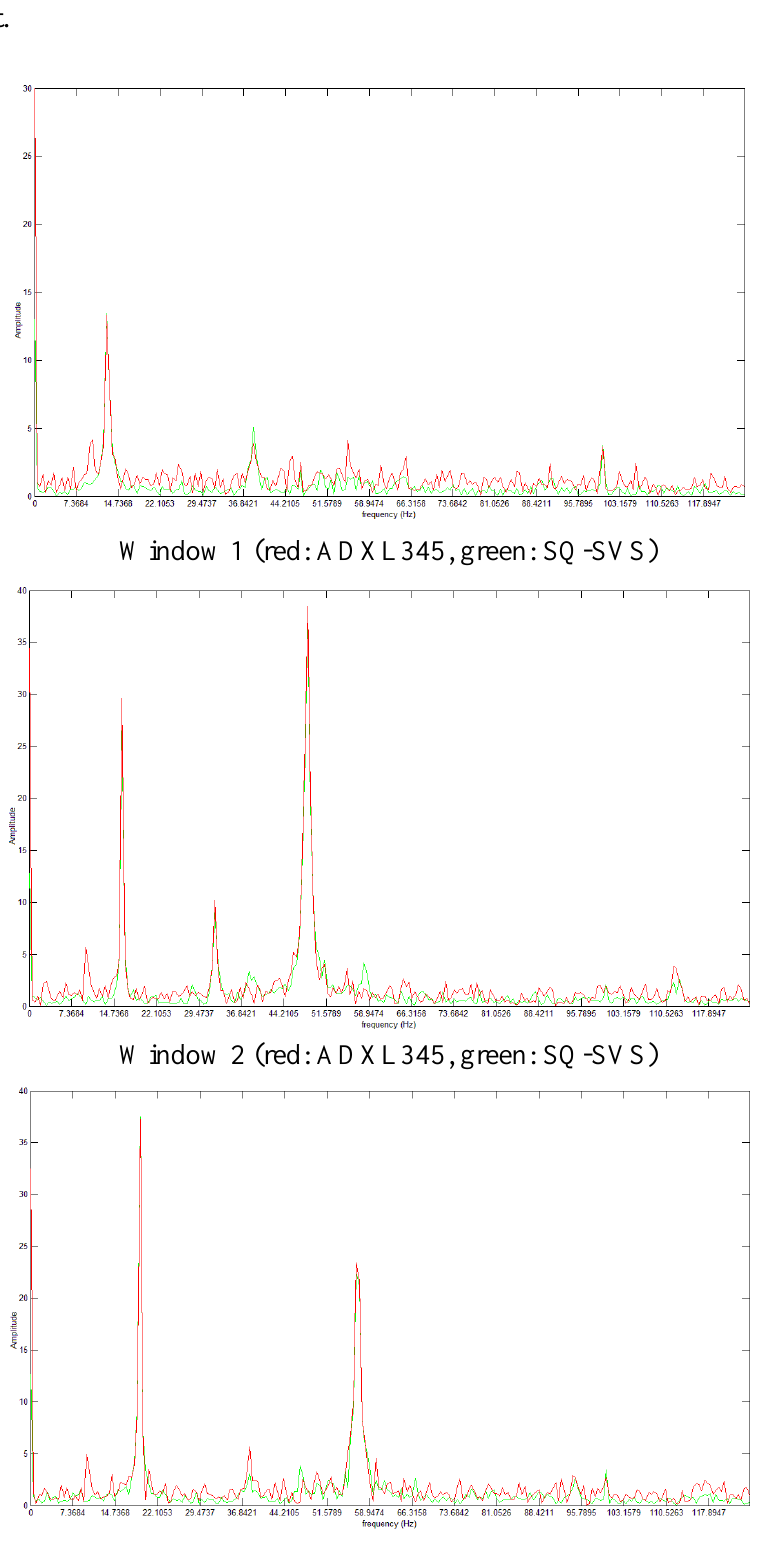
Figure 4. Frequency domain analysis of the raw data obtained in the